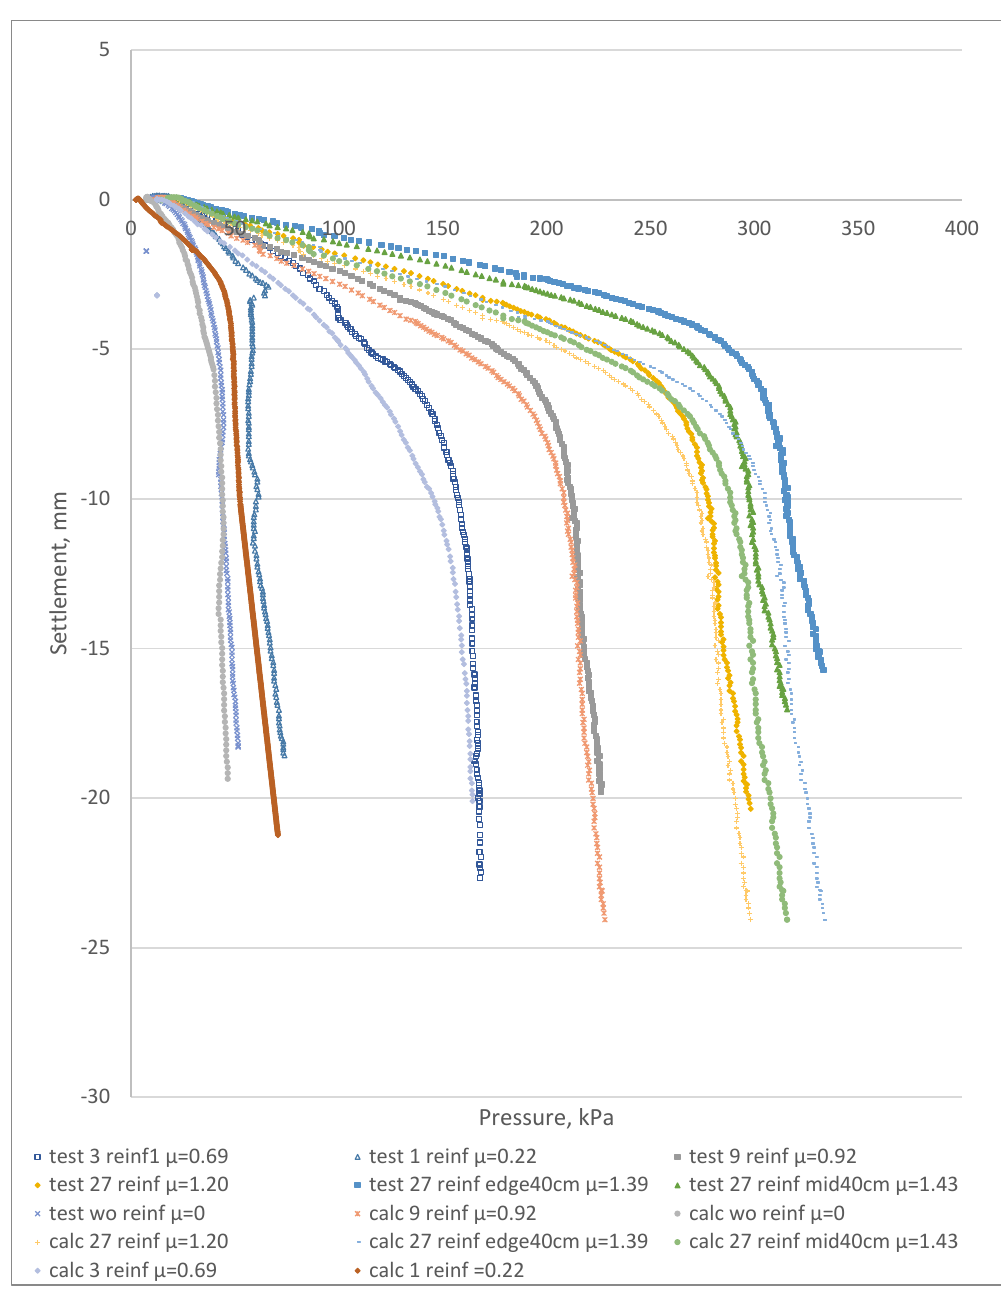
Figure 9. The load – settlement curves for the tested samples compared to the theoretical calculation results. Calculated results are specified by the term “ calc ”. Test results are specified by the term “ test ”. Reference samples without reinforcement correspond to “ test wo reinf µ = 0 ”. The legend specifies the number of reinforcing elements: 1, 3, 9 or 27 reinf. Elements with 40 cm extended lengths at the edges (sample No6) or at the middle (sample No 7) are specified as “ edge 40 cm ” or “ mid40 cm ” accordingly.